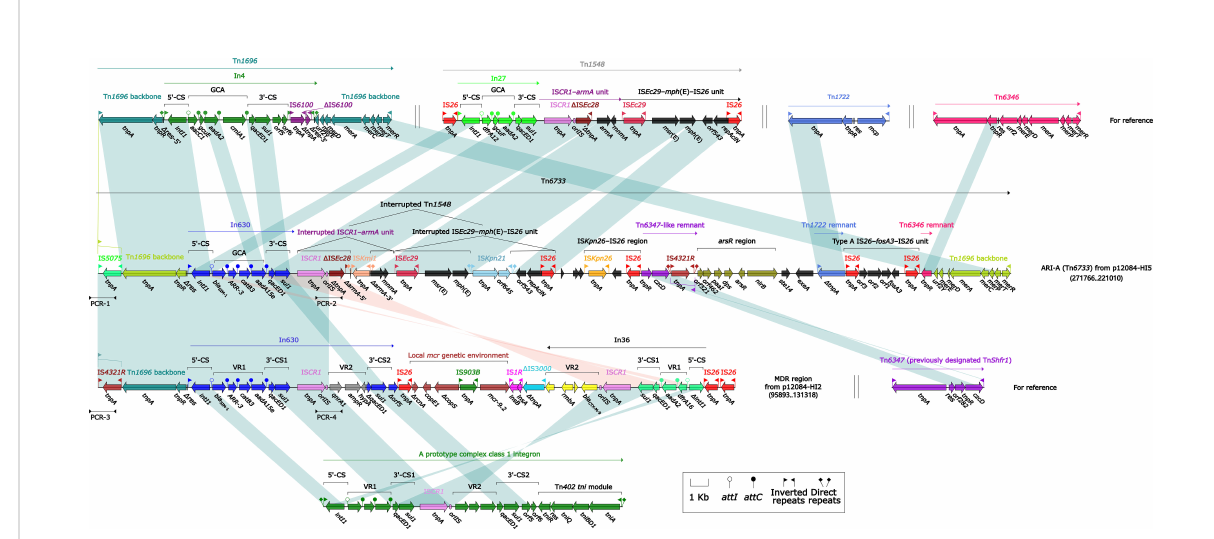
FIGURE 2 Organizations of the MDR regions of p12084-HI2, and p12084-HI5 compared with related reference regions. Genes are denoted by arrows. Genes, mobile elements, and other features are colored based on function classi fi cation. Shading denotes regions of homology (>95% nucleotide identity). Numbers in brackets indicate the nucleotide positions within the corresponding plasmids. The arrowheads indicate the locations of PCR primers and the expected amplicons. The accession numbers of Tn 1696 , Tn 1548 , Tn 1722 , Tn 6346 , and Tn 6347 for reference are U12338, AF550415, X61367, EU696790, and CP000447,